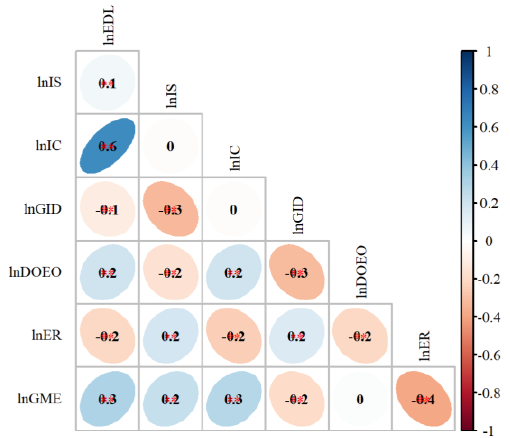
Figure 5. Plot of variable correlation coefficient test. Note: ** and * represent those whose significance levels are 0.01 and 0.05 respectively. 2 (cid:13) Collinearity diagnosis.